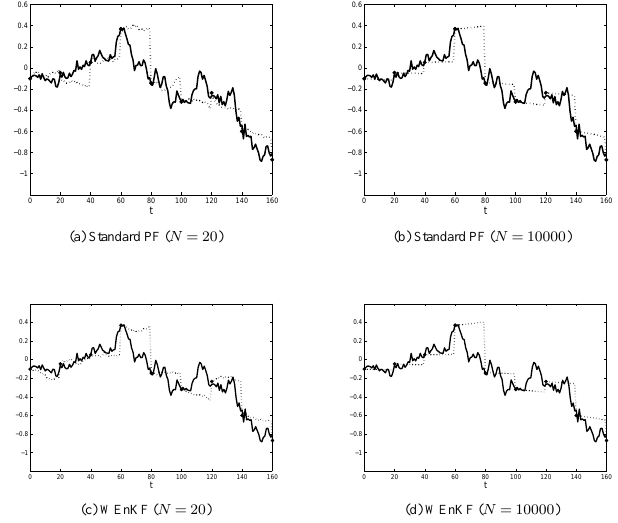
Figure 2. Standard PF and WEnKF results. Thick line: hidden dif- Fig. 2: Standard PF and WEnKF results. Thick line: hidden diffusion; Dots: partial observations; Dotted line: fusion; dots: partial observations; dotted line: estimated filtering estimated filtering mean.